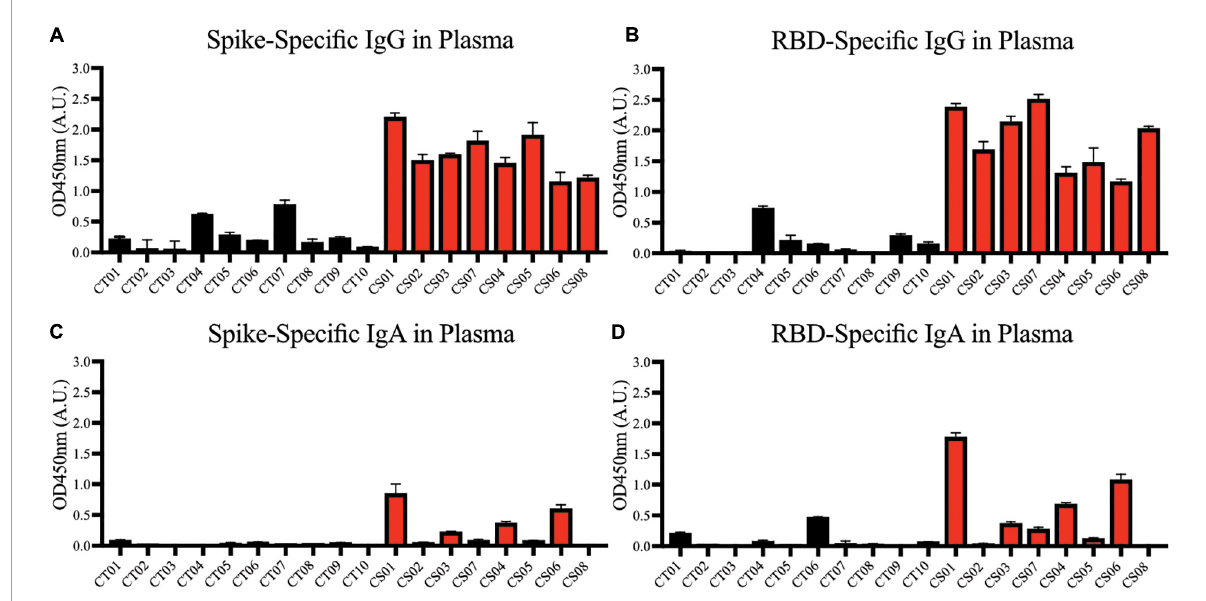
FIGURE2 Spike and RBD-specific IgG and IgA present in maternal plasma of convalescent mothers. Using a protein-based ELISA, maternal plasma from control (CT01- CT10) and convalescent (CS01-CS07) mothers obtained 1-month post-partum were used for the detection of spike (A,C) and RBD (B,D) specific IgG and IgA antibodies. The bar graphs represent the normalized average signals of antibodies binding to the respective proteins. Convalescent mothers (CS samples) are arranged in ascending order according to their time from COVID diagnosis to delivery.